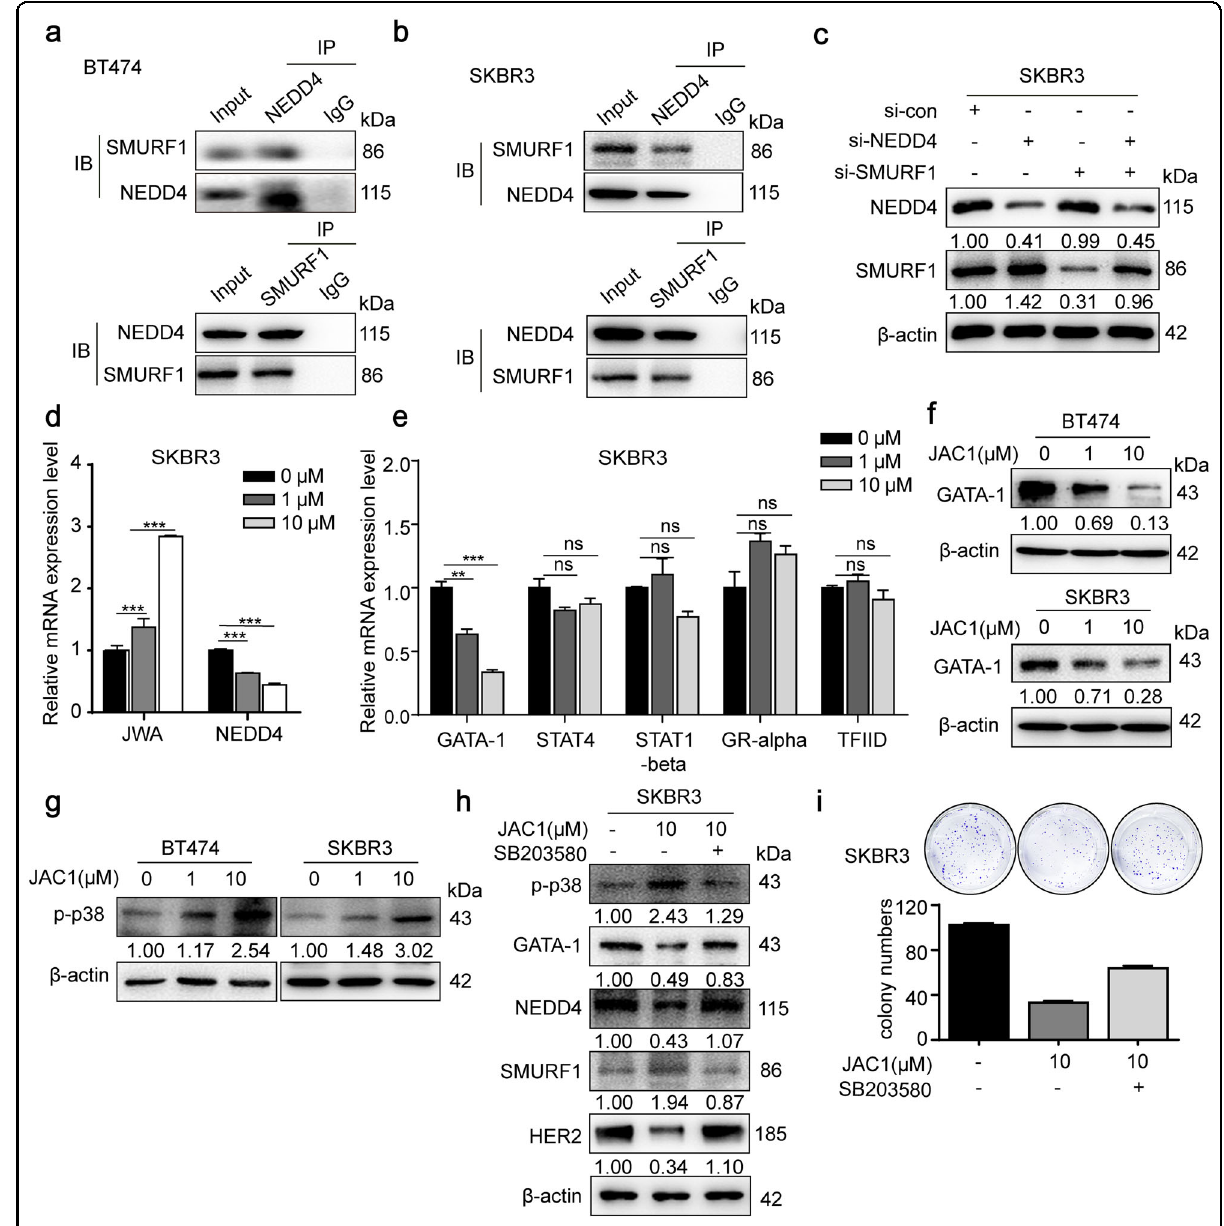
Fig. 5 JAC1 modulates SMURF1 through JWA-p38-GATA-1-NEDD4 axis. a , b The endogenous protein – protein interaction between NEDD4 and SMURF1 was identi fi ed by IP and western blot in both BT474 and SKBR3 cells. c Western blot analysis of NEDD4 and SMURF1 of SKBR3 cells transfected with si-NEDD4 or si-SMURF1. d The mRNA expressions of NEDD4 and JWA were detected by real-time PCR in SKBR3. The values were calculated as 2 − ddCT , and the relative fold change was compared to the control groups after being normalized to GAPDH. e The mRNA expressions of GATA-1 , STAT4 , STAT1-beta , GR-alpha , and TFIID were detected by real-time PCR in SKBR3. The values were calculated as 2 − ddCT , and the relative fold change was compared to the control groups after being normalized to GAPDH. f The regulations of JAC1 on GATA-1 were determined in both BT474 and SKBR3 cells. g JAC1-induced activation of p-p38 was determined by western blot in both BT474 and SKBR3 cells. h Western blot analysis of p-p38, GATA-1, NEDD4, SMURF1, and HER2 of SKBR3 cells treated with JAC1 or SB203580. i The inhibition of JAC1 on colony formation via the p38 MAPK pathway was determined in SKBR3